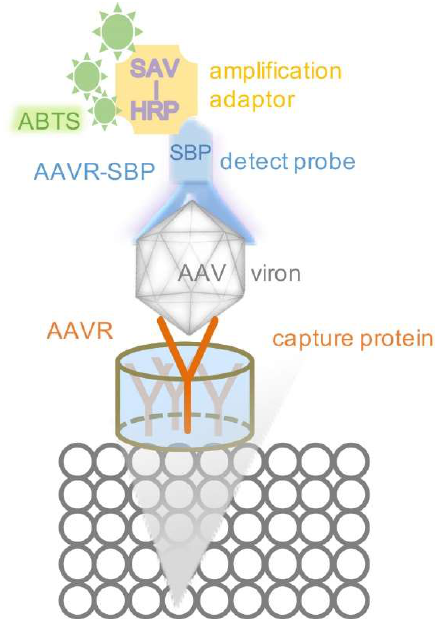
Figure 1. The principle of VIRELISA for schematic demonstration. The soluble AAVR was immobilized in the 96-well plate as the captured protein. AAV samples were loaded into each well. AAVR-SBP was used as the detection probe, equivalent to a primary antibody. Then SAV (streptavidin) conjugated with HRP (horseradish peroxidase) was applied as the amplification adaptor, as a secondary antibody. The ABTS (2,2′-azino-di-(3-ethylbenzthiazoline sulfonic acid)) was finally added to develop visual signals.